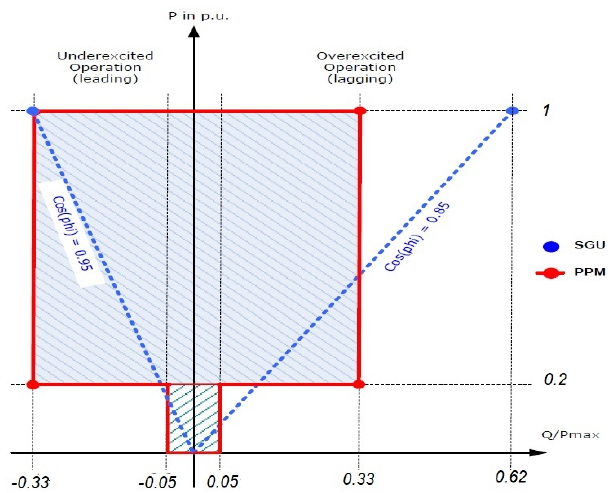
Figure 7. P ‐ Q Diagram (SGU: Synchronous generation unit; PPM: Power Park